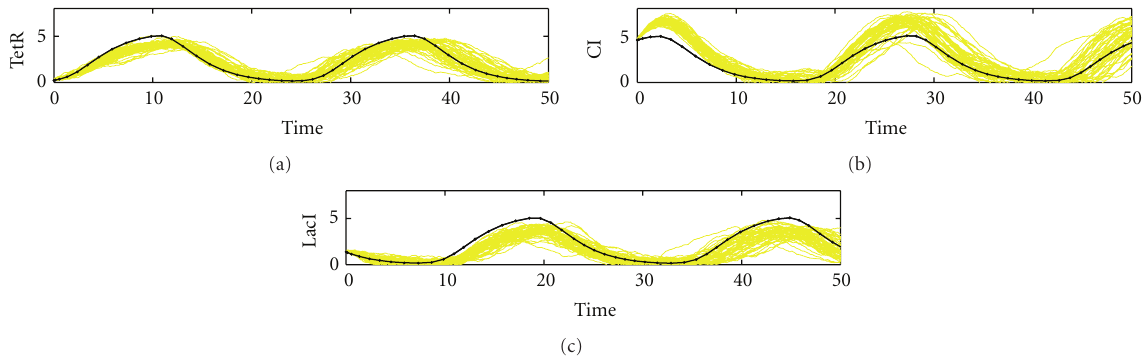
Figure 9: Simulation of biological repressilator: (a) TetR; (b) CI; (c) LacI. In contrast to the above design case, the design parameters are specified aside the best fit parameter k ∗ , for example, with k 1 = 1 . 5, k 2 = 1 . 9, k 3 = 1 . 2, k 4 = 0 . 79, k 5 = 1 . 1, and k 6 = 0 . 96. In this design case, the mean errors e are 0.91, 1.36, and 1.18 with standard deviations of 0.29, 0.35, and 0.27 for TetR, CI, and LacI,